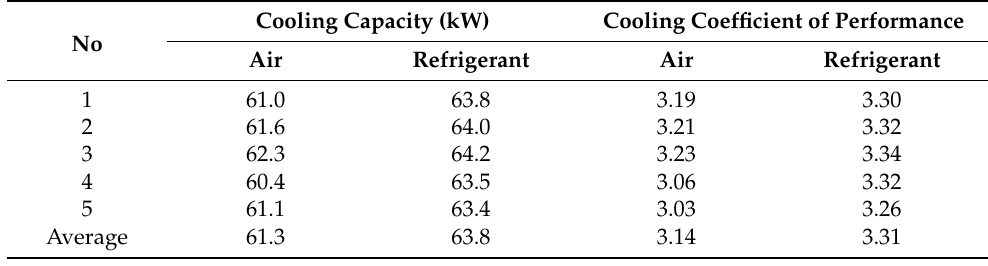
Table 15. Air side and refrigerant side cooling performance result (five times).